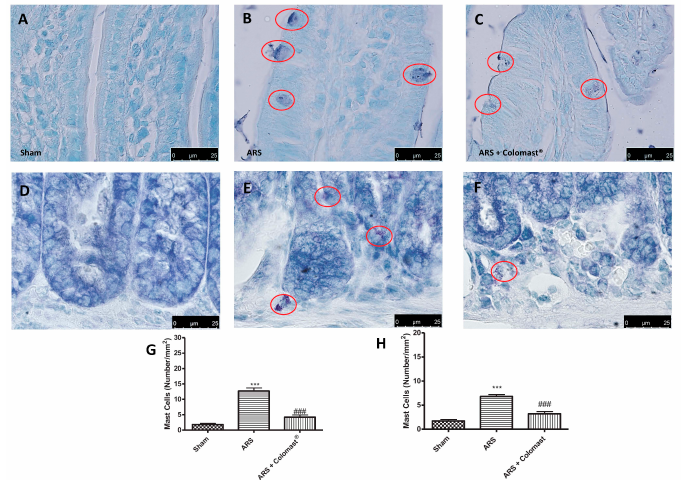
treatment with Colomast ® (Figure 4C,G). At the same way, Colomast ® reduced the number of activated mast cells (Figure 4F,H) in colon sections compared to the ARS group (Figure 4E,H).